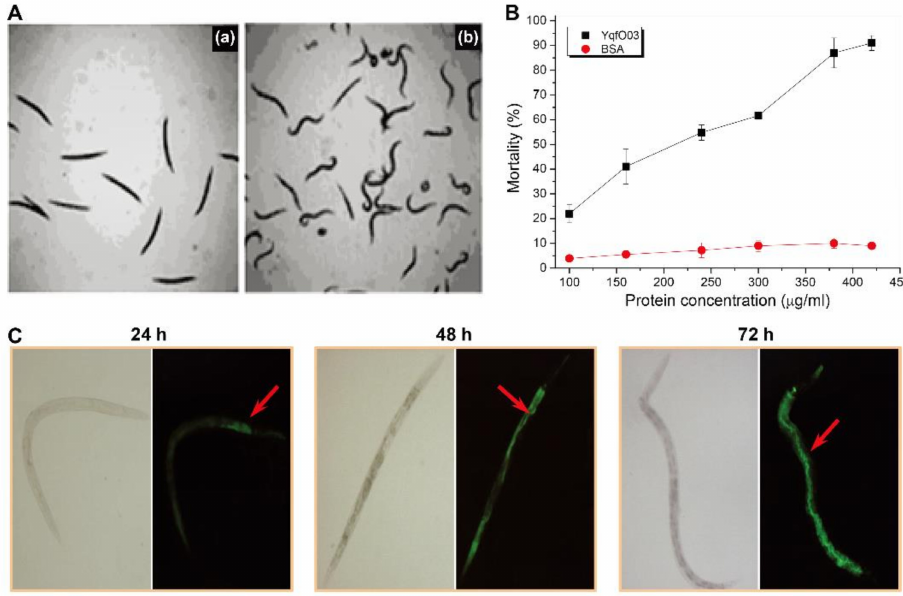
Figure 2. ( A ) Comparative morphology of C. elegans worms after treatment with YqfO03 protein, ( B ) nematicidal activity assay of purified YqfO03, and ( C ) in vivo distribution analysis of purified YqfO03 in worms. ( A ) ( a ) worms after feeding with 500 µ g/mL YqfO03. Nematode death was confirmed by transferring the individuals into new plates containing sterile water, and the individual worm that did not respond after being touched several times with a platinum pick were marked as dead. The dead worms remained rigid and straight; ( b ) worms treated with bovine serum albumin (BSA). Worms were active and wavy with constant motion. ( B ) Mortality assays of C. elegans that were treated with various concentrations of purified YqfO03 at concentrations of 100, 160, 240, 300, 380, and 420 µ g/mL, respectively. Error bars represent the standard deviations from the means of three independent experiments. ( C ) Worms were fed with purified FITC-labeled YqfO03 (200 µ g/mL). Worm morphology and fluorescence signal were observed by fluorescence microscopy at 24, 48, and 72 h (dark background). FITC alone was used as the control (gray